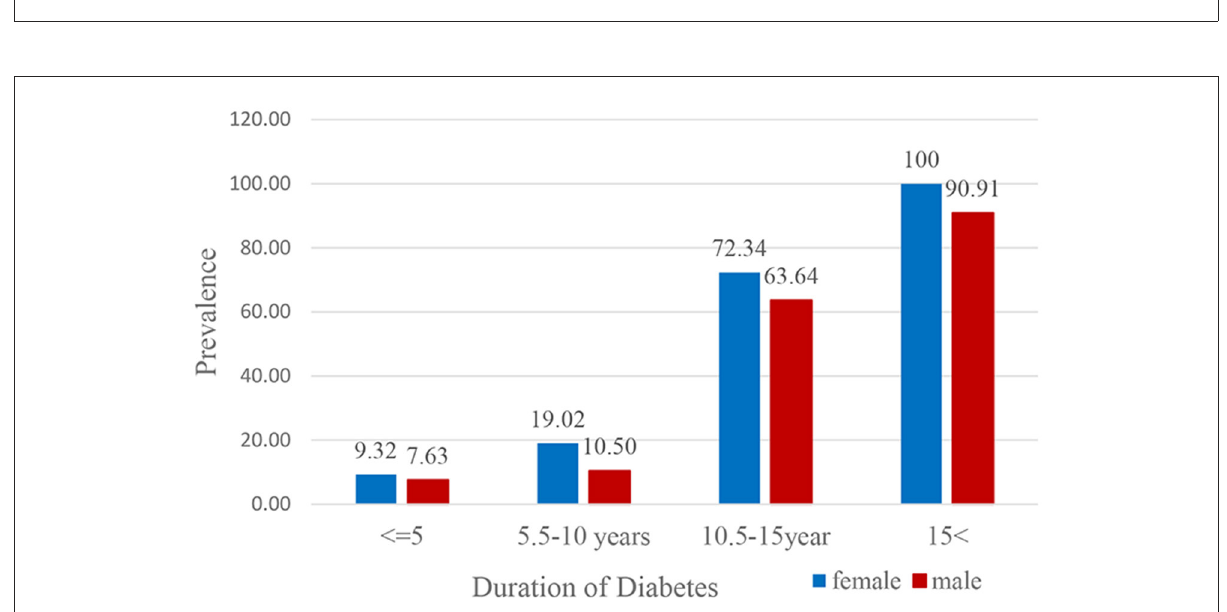
FIGURE2 Prevalence of diabetic foot ulcer in diabetic subjects according to the duration of